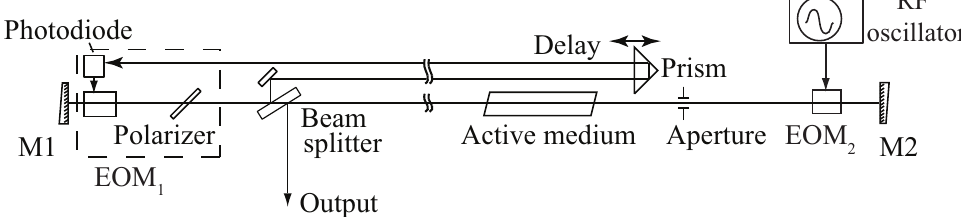
Figure 1. The simplified scheme of a master picosecond oscillator: a delayed-feedback-controlled harmonically mode-locked laser with external RF modulation. M1, M2 are resonator mirrors; EOM 1 is electro-optical modulator for SSHML, EOM 2 is the electro-optical modulator for synchronization, delay T d is set to (cid:39) ( 1 − 1/ m ) T r by shifting the